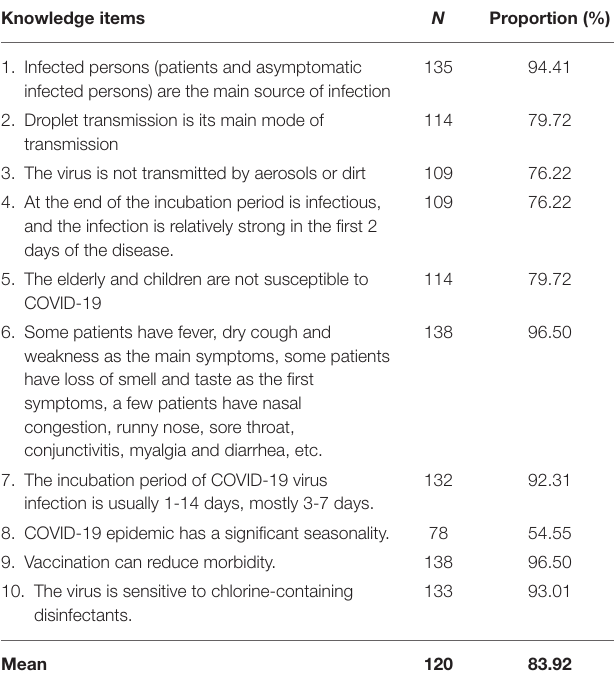
TABLE 1 | Participants’ correct responses to questions bordering on knowledge of COVD-19 ( n =